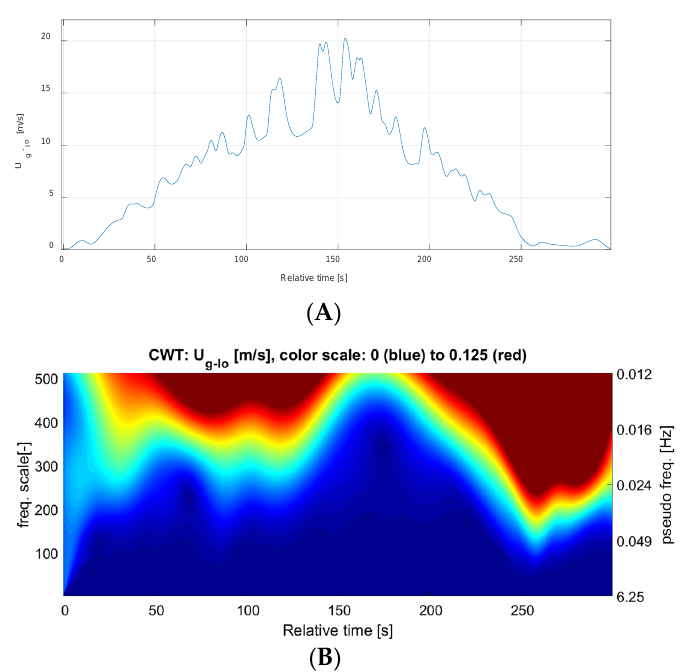
Figure 15. ( A ) Absolute value of headwind speed estimation ( U g-lo ) based on GS x and TAS; ( B ) continuous wavelet analysis of data from ( A ).